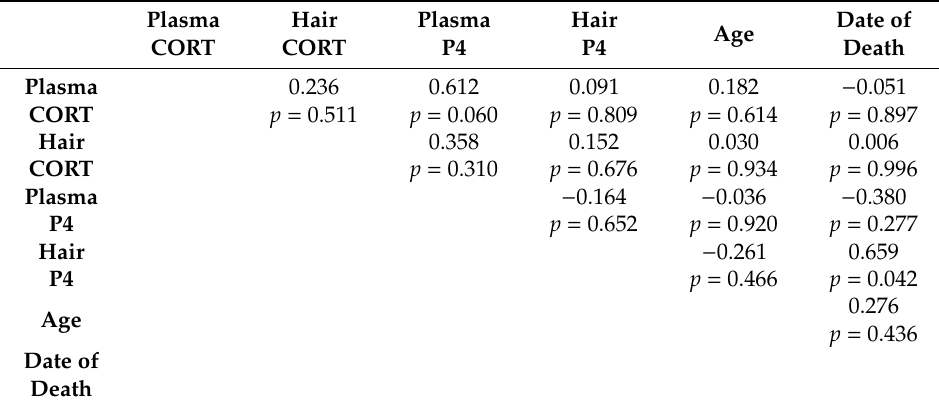
Table 2. Spearman rank correlation coe ffi cients ( ρ ) table with p values (95%